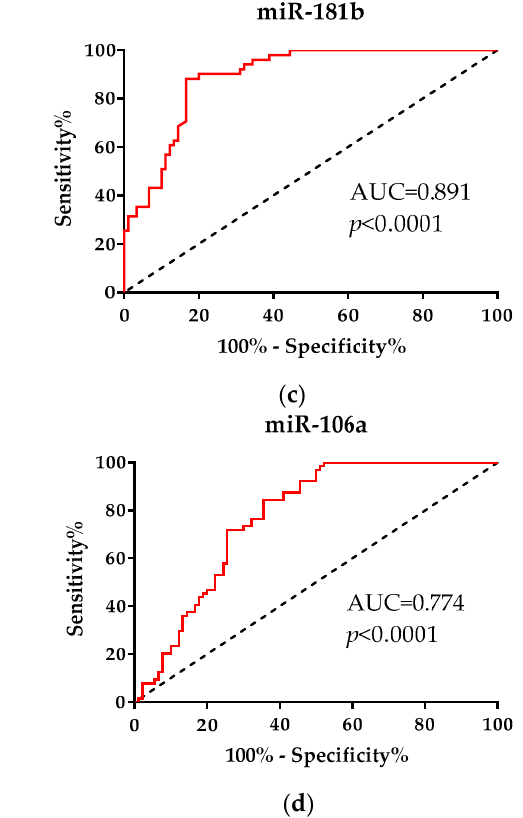
0.040 M+—positive for RAS mutations; WT—wild type; PS (ECOG)—performance status (Eastern Cooperative Oncology Group); ULN—upper limit of normal; CEA—Carcinoembryonic antigen. 2.6. Expressions of miR-181b as a Target for hsa_circ_0001445 and of miR-106a as a Target for